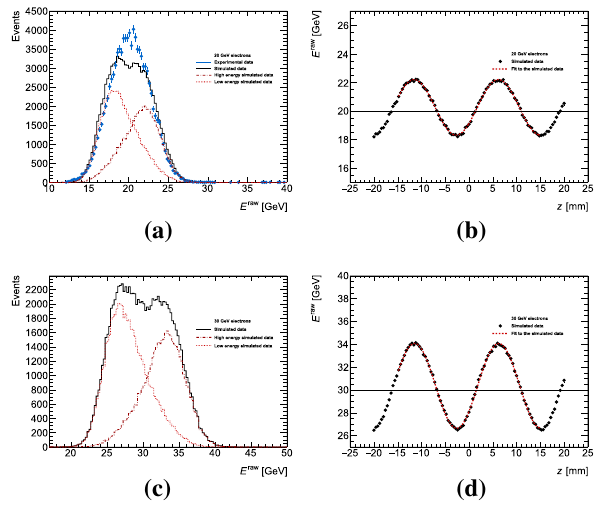
Fig. 15 The black histograms in a and c show the distributions of the reconstructed energy E raw obtained using simulated electron beams with E beam equal to 20 GeV and 30 GeV, respectively. The blue dot distribution in a has been obtained using experimental data (Sect. 3.4). The distributions obtained using “high energy events” (red dashed line) and “low energy events” (red dotted line) discussed in Sect. 5.1 are shown in (a) and (c). The histograms ( b ) and d show the oscillation of theelectronresponse duetothesamplingfractionvariationsasobtained using simulated electrons with E beam equal to 20 GeV and 30 GeV, respectively (Sect. 5.1). The dashed curves in red correspond to the fit of Eq. 10 to the data. The horizontal black line corresponds to the electron mean energy parameter p 0